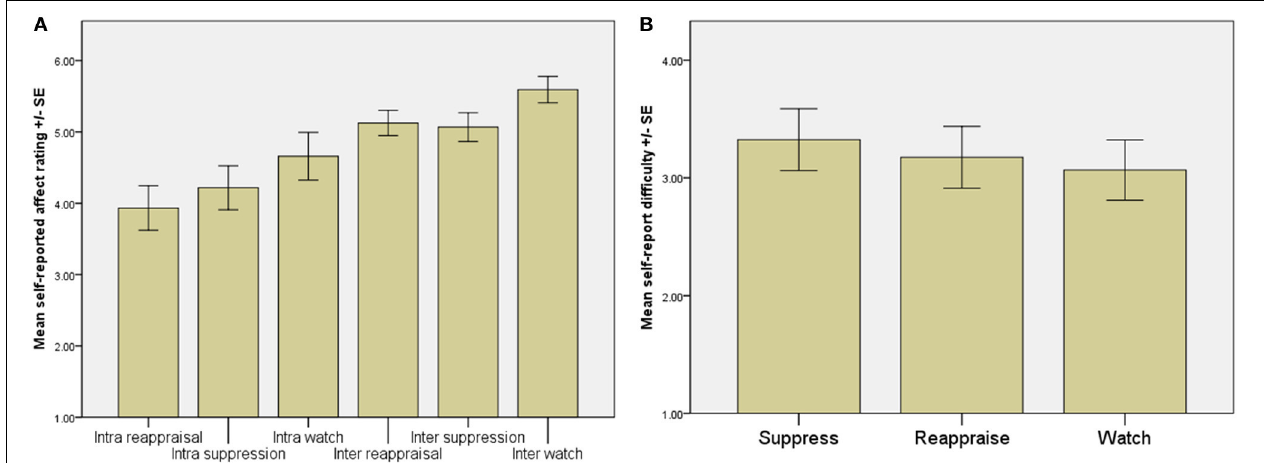
FIGURE 2 | (A) Mean ratings for how emotional the participants felt (intrapersonal scan) or how emotional the participant judged the other person to be (interpersonal scan). There was a main effect of regulation strategy [ F (2 , 38) = 8 . 04, p < 0 . 01]. For intra- and interpersonal scans, emotions were higher in the watch condition in comparison to both the suppression ( p < 0 . 05, p < 0 . 001 for intra- and interpersonal regulation, respectively) and reappraisal ( p < 0 . 01, p < 0 . 001) conditions. During intrapersonal regulation, ratings were also significantly higher for